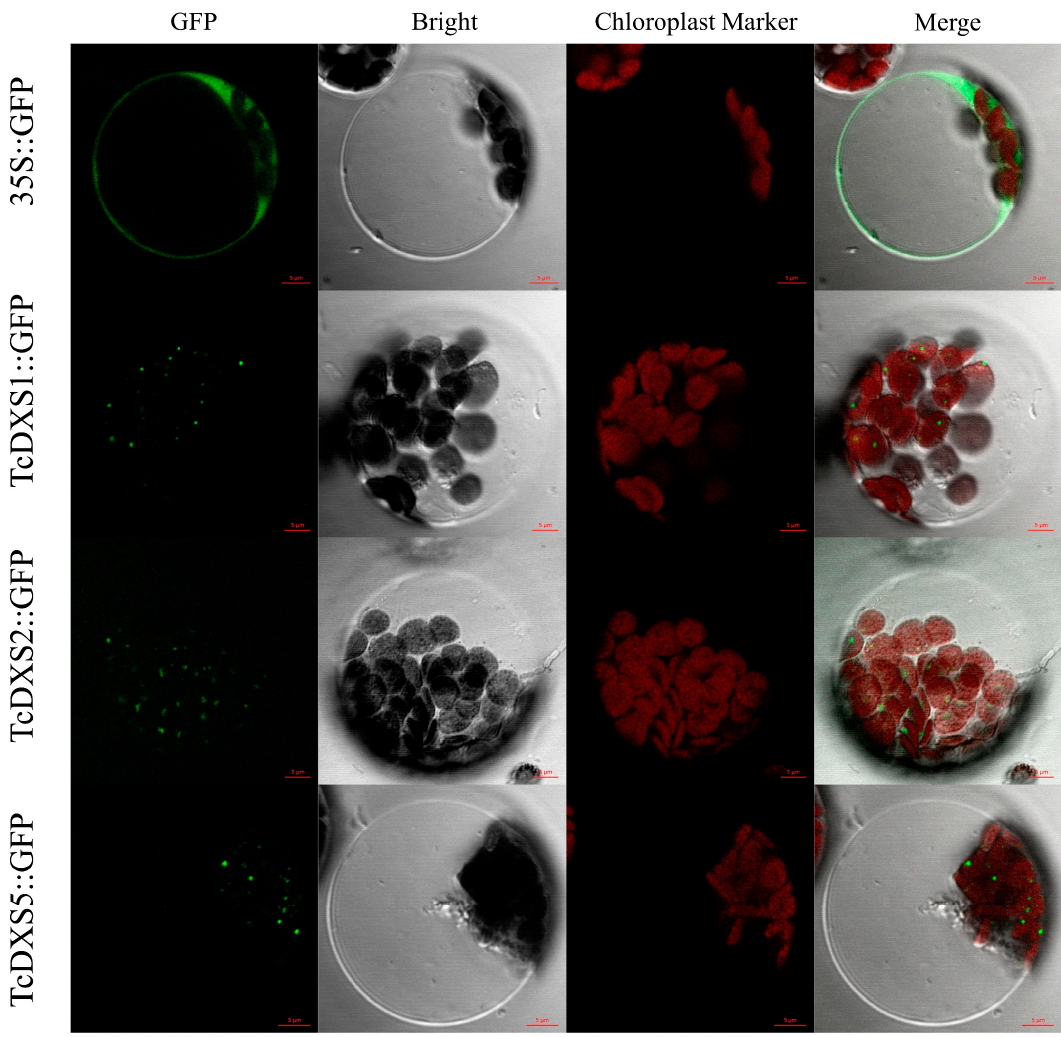
Figure 9. Subcellular localization of all TcDXS1, TcDXS2 and TcDXS5 proteins in the chloroplast envelope membrane of A. thaliana .